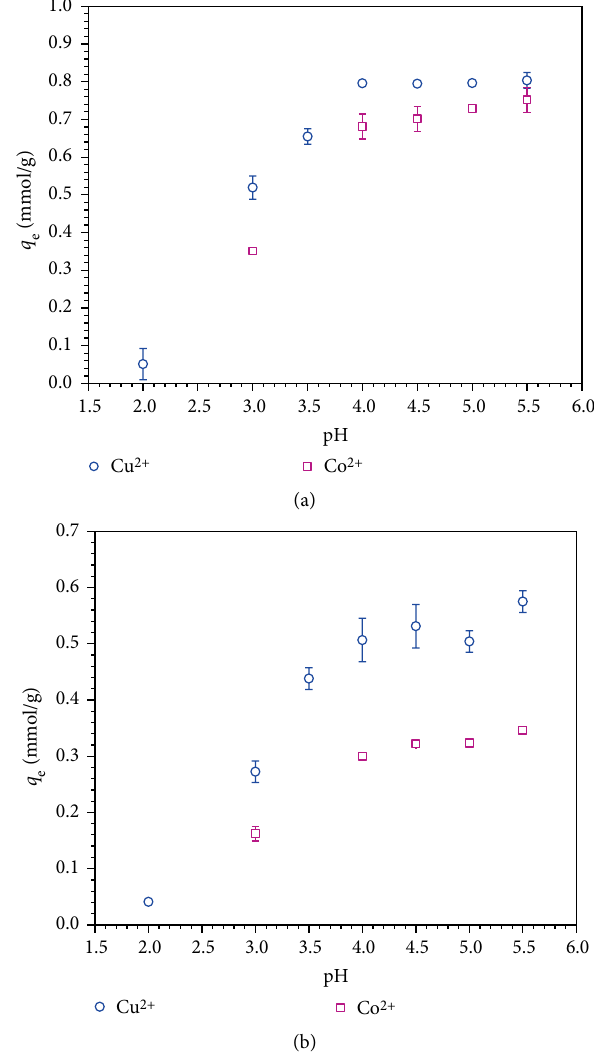
Figure 1: Effect of initial solution pH on the adsorption of Co 2+ and Cu 2+ on (a) Cox and (b) SBox (contact time of 4 h, 0.79 mmol/L Cu 2+ , 0.85 mmol/L Co 2+ , 25°C, 150 rpm, 0.2 g/L Cox or